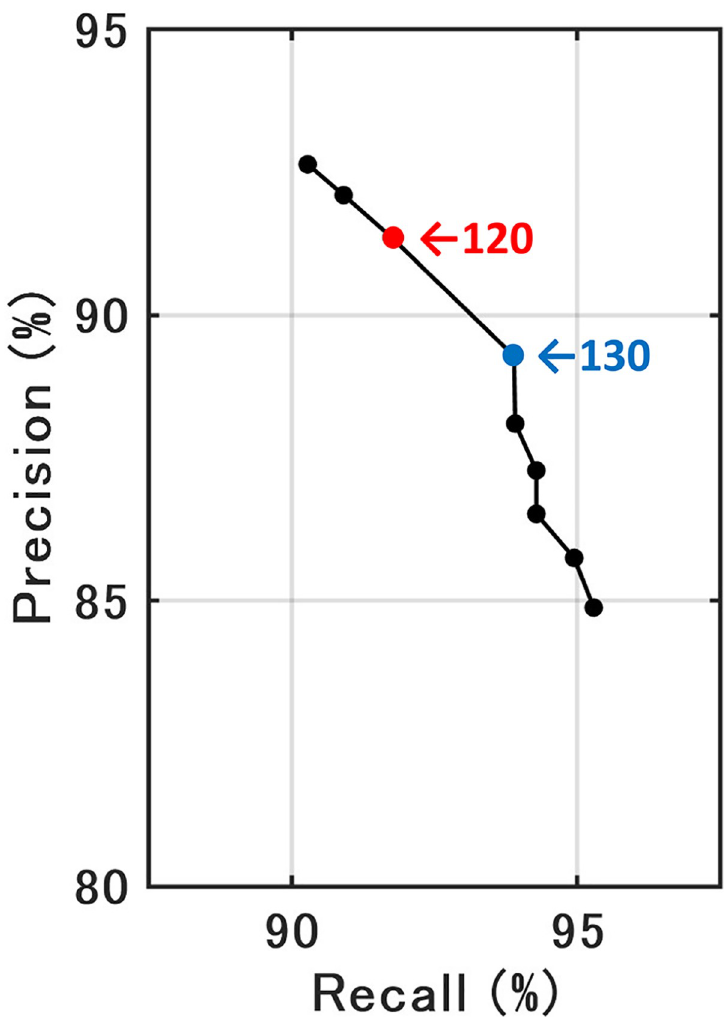
Fig 5. Precision-recall curve at various luminance threshold values for binarization of the integrated image. The red and blue arrows highlight the optimum values. 2.4.3 Evaluation. The F1 score was used to assess the accuracy of the model, as it is gener- ally used for evaluations in the field of pixel-based extractions. It was calculated based on the true positives TP (pixels extracted correctly as feeding trails), false positives FP (pixels extracted incorrectly as feeding trails), and false negatives FN (pixel extracted incorrectly as not feeding trails). Since the F1 score is defined as (Eq 1), the harmonic average of the preci- sion is defined as (Eq 2), and the recall which is defined as (Eq 3), the F1 score was an ideal metric for the evaluation of both the precision and recall at the same time [71].